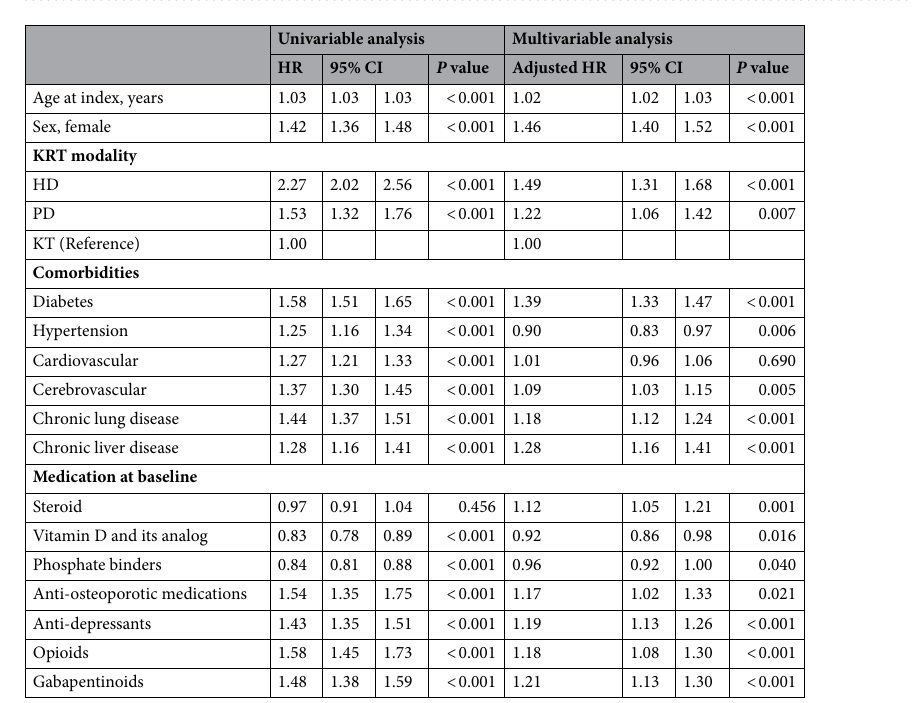
Figure 3. Cumulative incidence of fracture risk in patients with end-stage kidney disease undergoing KRT. KRT kidney replacement therapy, HD hemodialysis, KT kidney transplant, PD peritoneal dialysis.